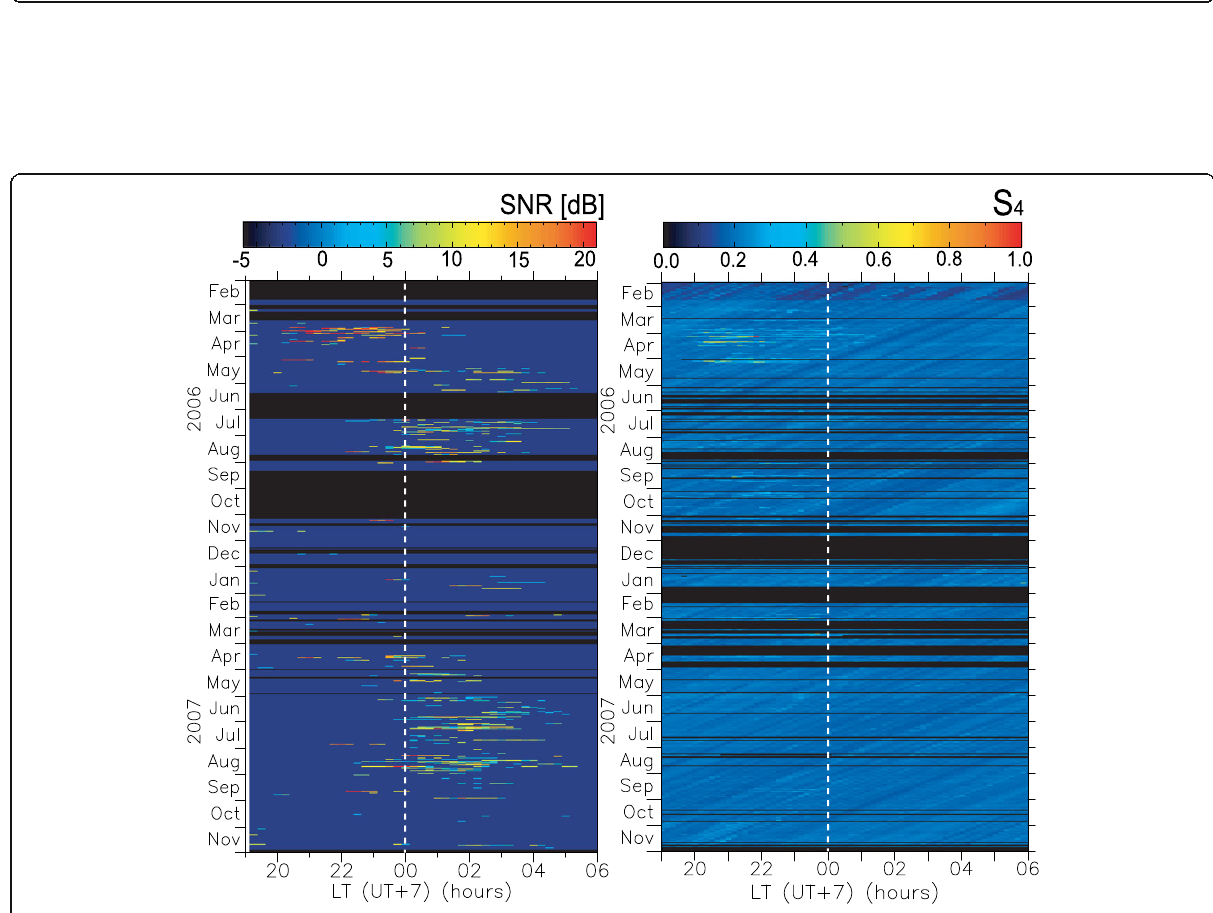
Fig. 8 Seasonal and local time variations of (left) F -region FAI echoes and (right) scintillation index (S4) observed at Kototabang between February 2006 and November 2007 (after Otsuka et al.